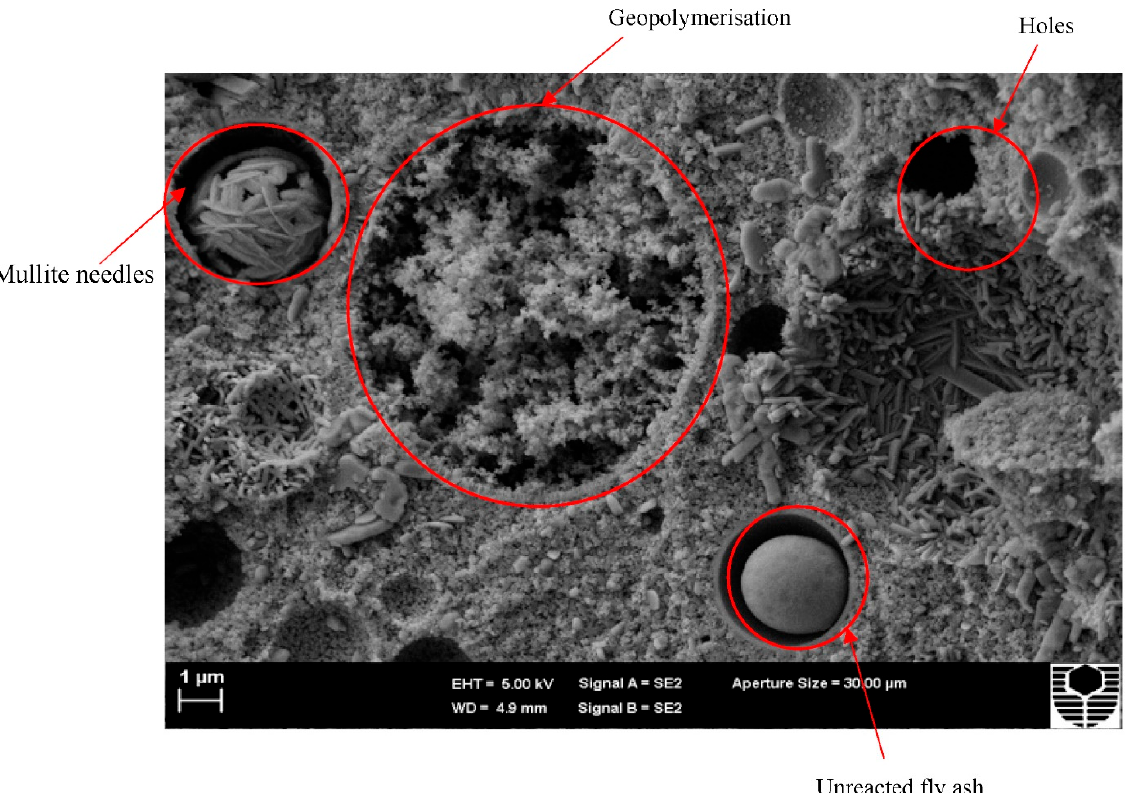
Figure 4. Microstructure of FA-based geopolymer.